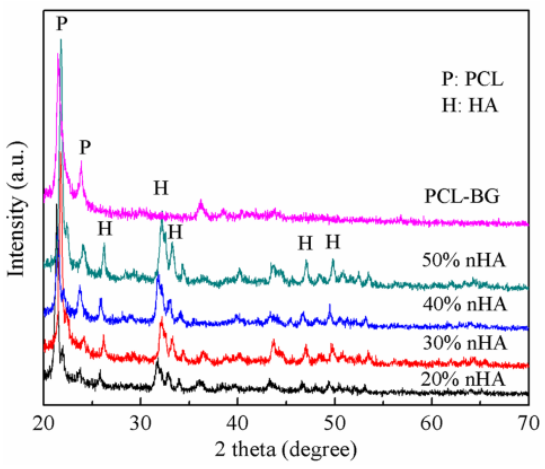
Figure 8. XRD patterns of the nHA-PBP hybrid membranes with different nHA contents after biomineralization in SBF for 7 days. Representative diffraction peaks of hydroxyapatite were marked in the patterns.